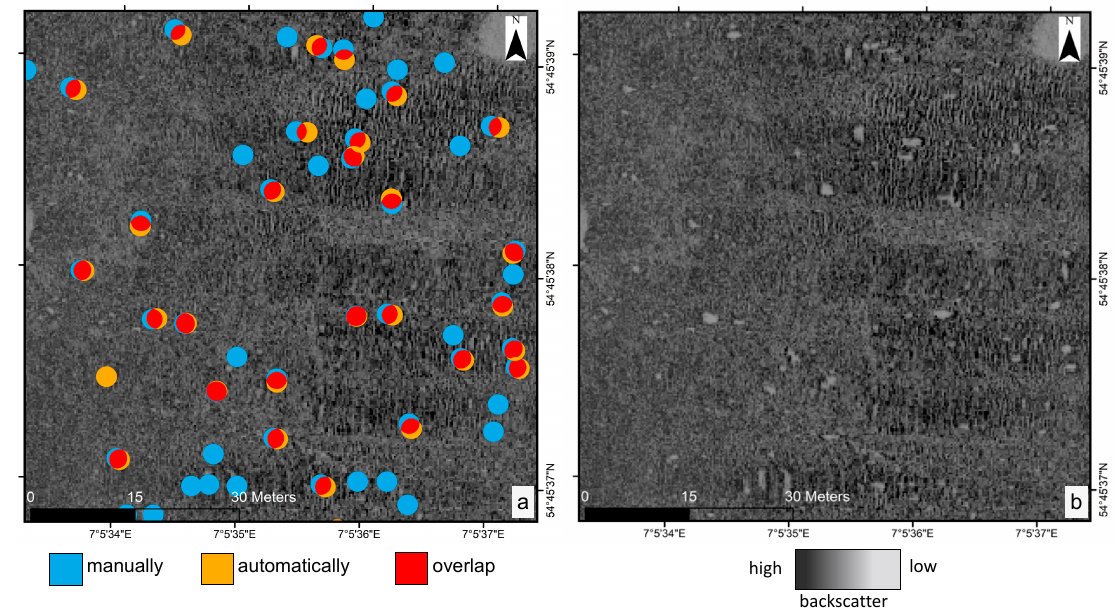
Figure 3. Manually (blue) and automatically (orange) detected stones on an SSS mosaic (25-cm resolution) with buffer sizes of 3.00 m ( a ). The red area indicates the largest overlap between two spatially matching stones. The underlying SSS mosaic is shown in ( b ). White areas indicate the acoustic shadows of the stones.